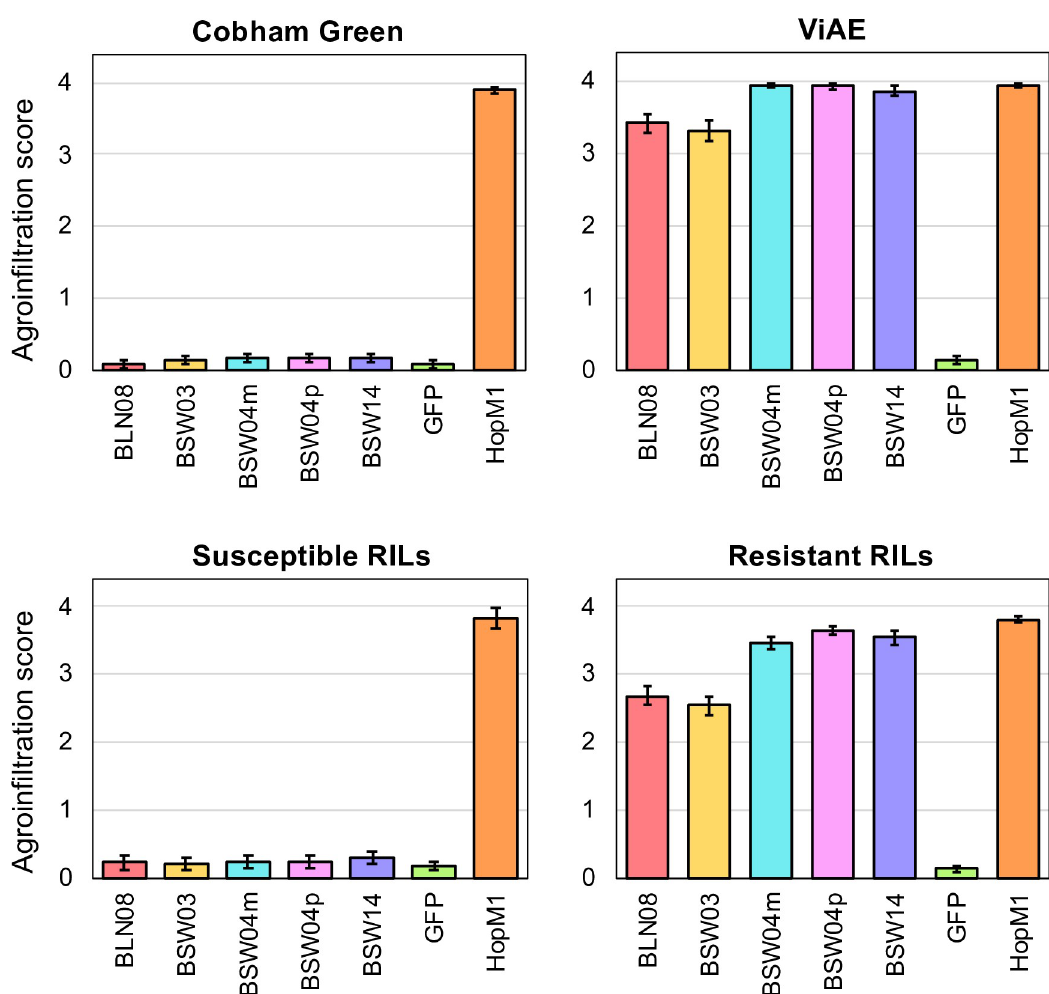
Fig 9. Agroinfiltration scores of the ViAE x Cobham Green RILs in response to the five effectors recognized by ViAE. Scores as in Fig 7. Candidate effectors were expressed in lettuce leaves using Agroinfiltration and leaves were scored for their reaction three to five days post-infiltration. GFP was used for a negative control and HopM1 used as a positive control for all leaves; only leaves showing the appropriate response to both were scored. Sample sizes for each group are 35 plants of Cobham Green, 45 plants of ViAE, 18 lines of susceptible RILs (88 plants), and 44 lines of resistant RILs (205 plants). Bar plot shows average scores with standard error